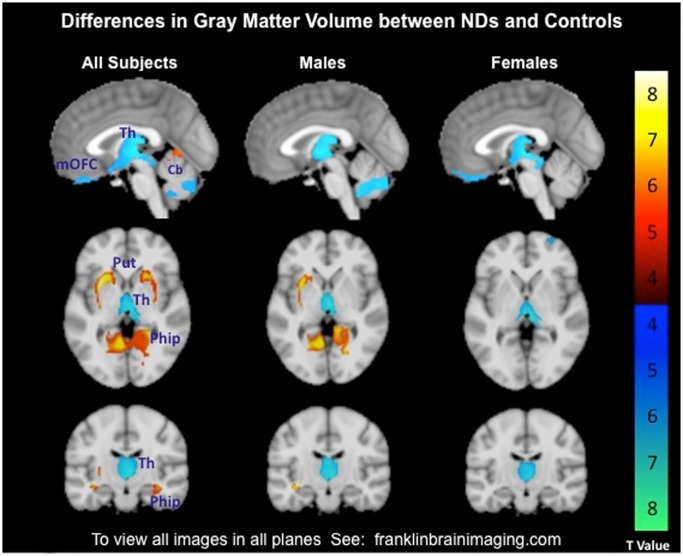
Differences in gray matter volume (GMV) between nicotine dependent (NDs; n = 80) and control subjects (Controls; n = 80) shown in all subjects and separately by sex (NDs, n = 41 male; Controls, n = 41 male).Representative MRI sagittal, axial, and coronal brain slices analyzed in SPM8 and overlain on the Montreal Neurological Institute brain. Slice shown is centered within the thalamus (x, y, z; 0, −16, 0). Hot colors represent regions of greater GMV, while cool colors represent regions of less GMV in NDs compared to Controls. T values range from 4.42 to 8.06, significant in whole brain analysis at p<0.001, and FWE cluster-corrected p<0.025. Images are displayed neurologically. An interactive visual display of all brain data in all three planes can be found at http://franklinbrainimaging.com (Available upon publication).